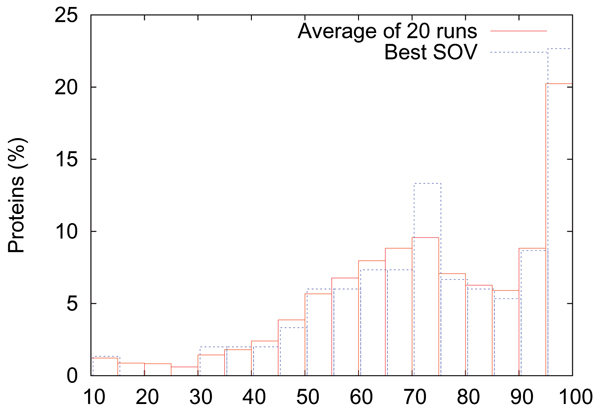
SOVα accuracy histogram. Histogram showing the distribution of SOVα across proteins in the test set. We have shown the average case, and the best of the 20 runs which has the highest SOVα.